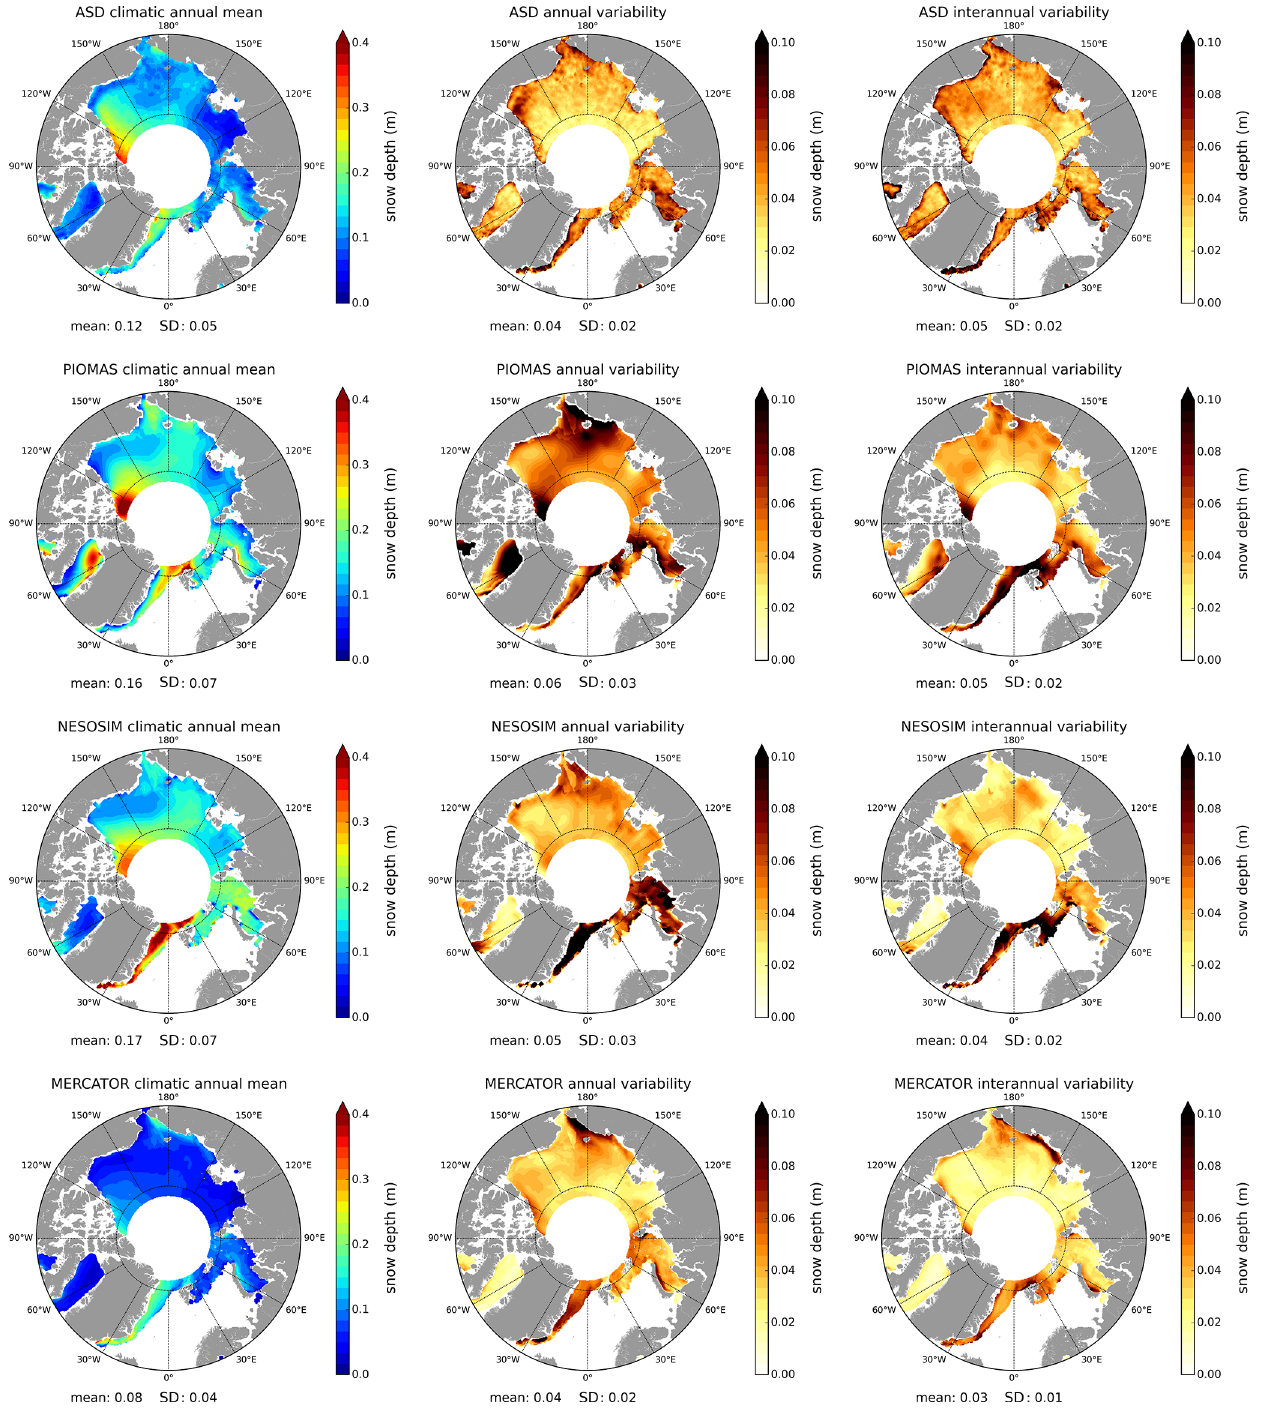
Figure 4. Comparisons between the ASD data and model snow depth products (PIOMAS, NESOSIM, MERCATOR) in the Arctic. The first column presents the “climatic mean” snow depth maps, the second column the “annual variability” and the third column the “interannual variability” as presented in Sect. 4.1. These diagnoses are calculated from March 2013 to April 2019 for ASD (first row), PIOMAS (second row) and MERCATOR (fourth row) and from March 2013 to April 2017 for NESOSIM (third